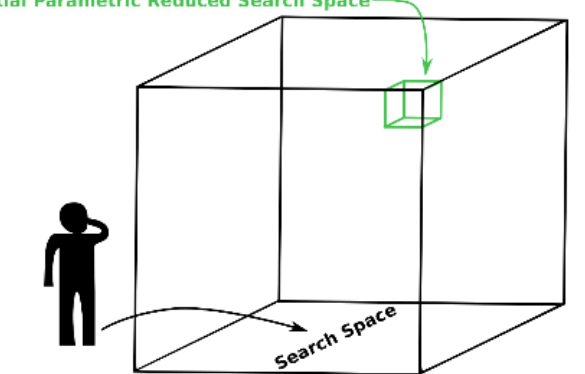
Figure 6. Room analogy: The analyzer knows there is a resource and time constraint to scan the entire room for the potential optimal parametric match. However, based on previous experience (or previous research) he knows that there is a reduced search region that could lead to a good solution to the problem (not necessarily the optimal one). Source: own authors.